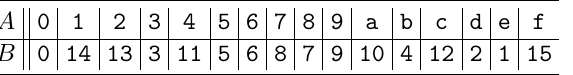
Table 15: The mapping of the binary